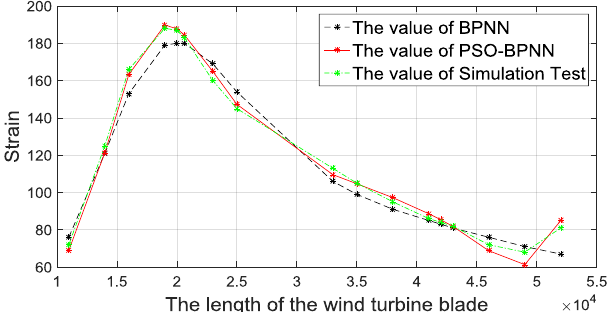
Figure 12. Comparisons of BPNN methods with the FEA.